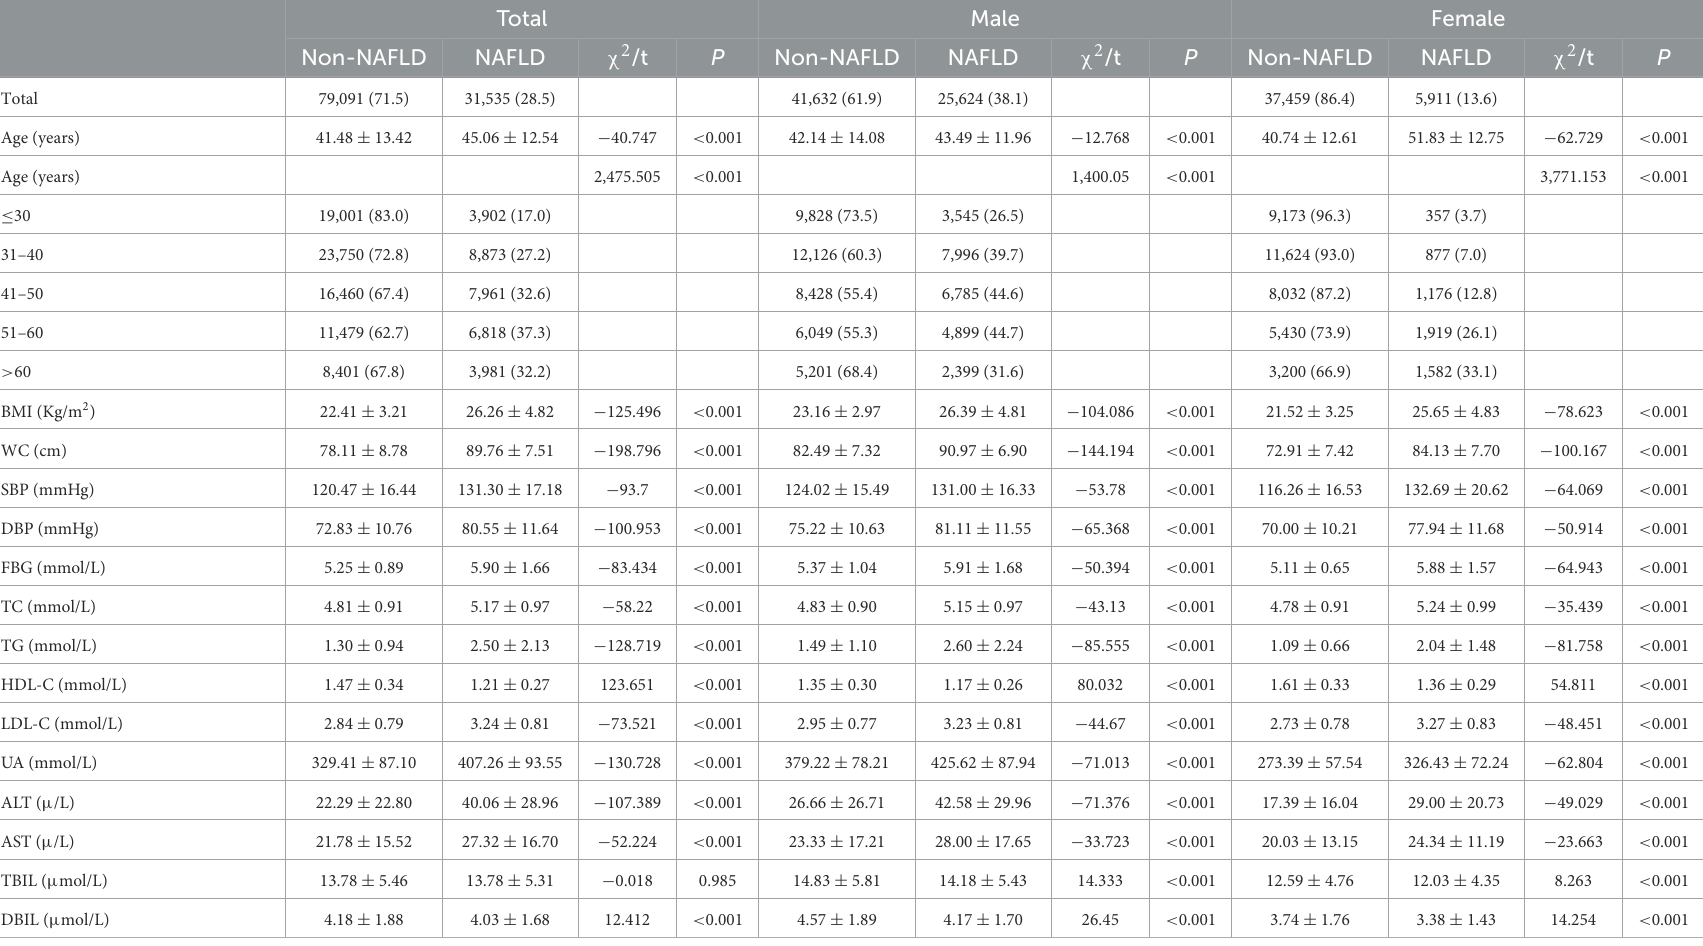
TABLE 1 Baseline characteristics of the subjects ( N =